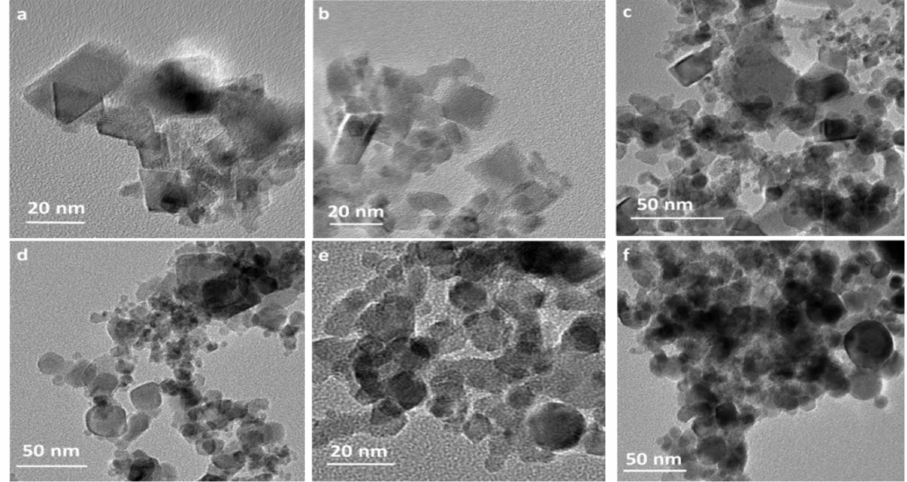
Figure A3. Morphologies of the prepared samples: ( a ) Pure CeO 2 ; ( b ) 1% CuCe; ( c ) 5% CuCe; ( d ) 9% CuCe; ( e ) 14% CuCe; ( f ) 17% CuCe.